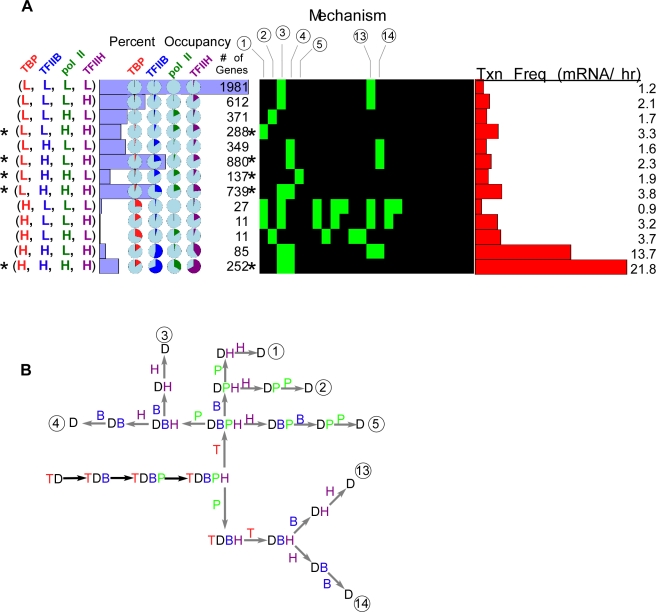
Four factor (TBP, TFIIB, Pol II, and TFIIH) modeling of genome-wide ChIP occupancy data.
A–B, See Figures 1 and 2 for panel descriptions.